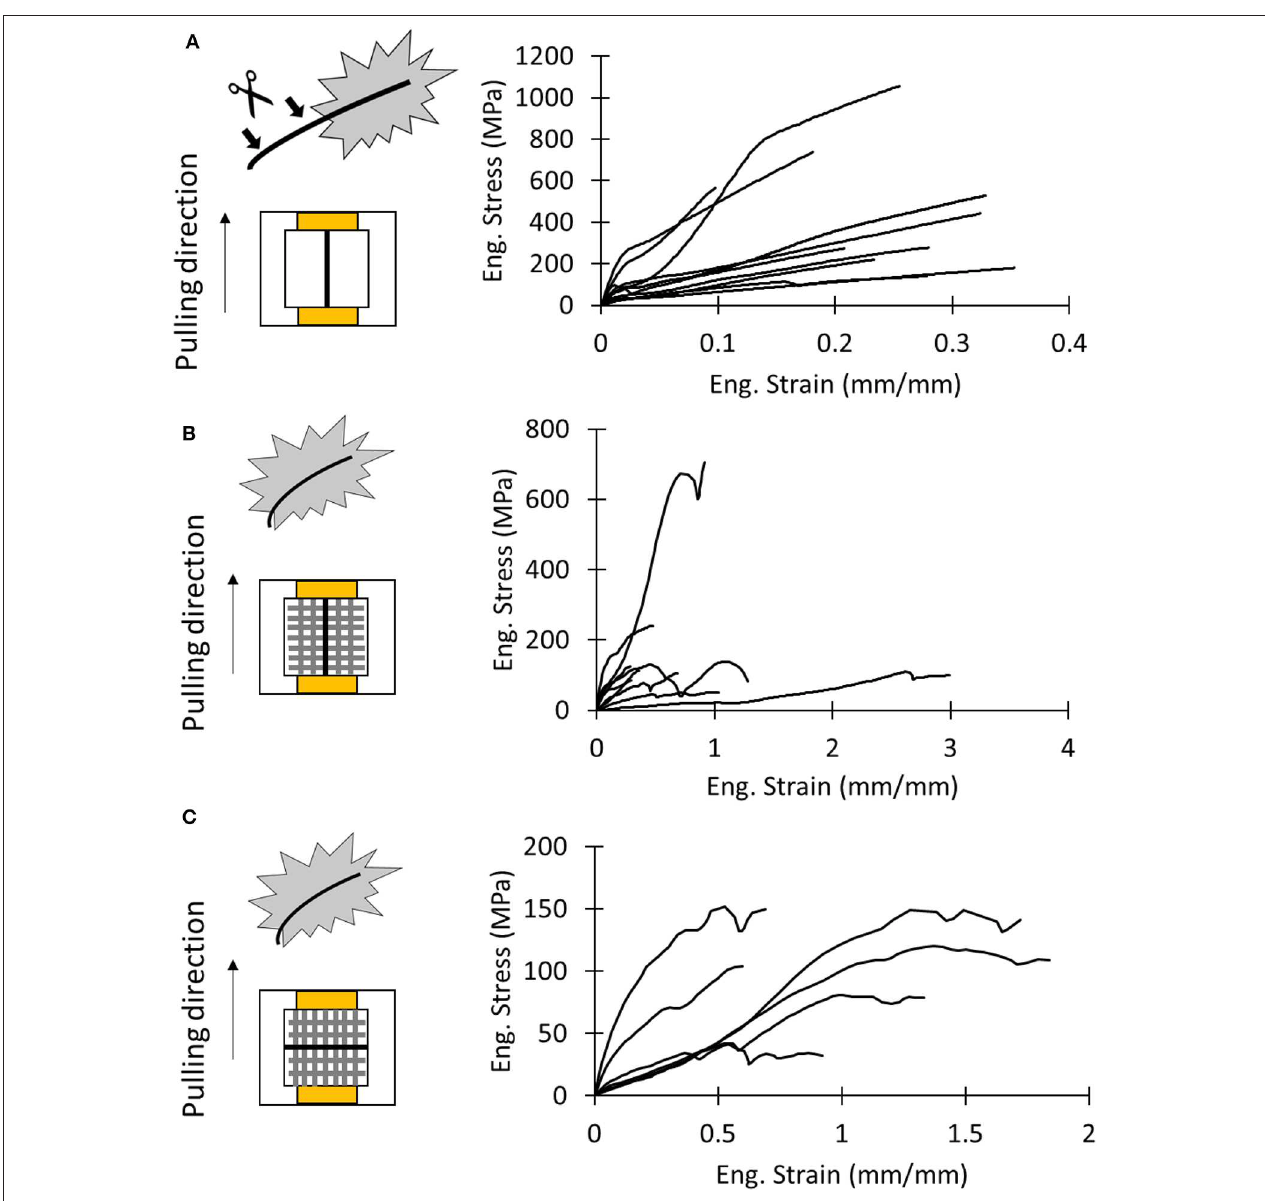
FIGURE 5 | (A) Schematics of test sample and stress–strain curves of dragline samples. (B) Schematics of test sample and stress–strain curves of the attachment disc pulled in the dragline direction (y direction). (C) Schematics of test sample and stress–strain curves of the attachment disc pulled in the pure fibrils direction (x